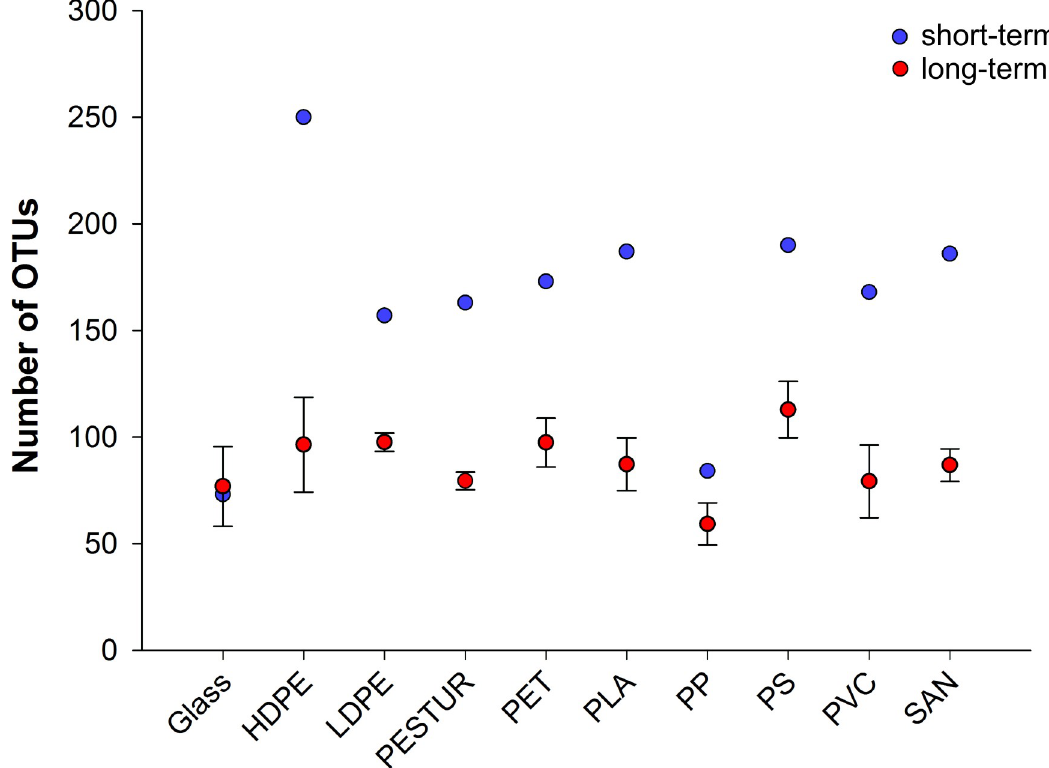
Fig 4. Richness of the bacterial communities attached to the diverse substrates based on the number of observed OTUs. Vertical bars denote the standard deviation (n short-term = 1; n long-term =